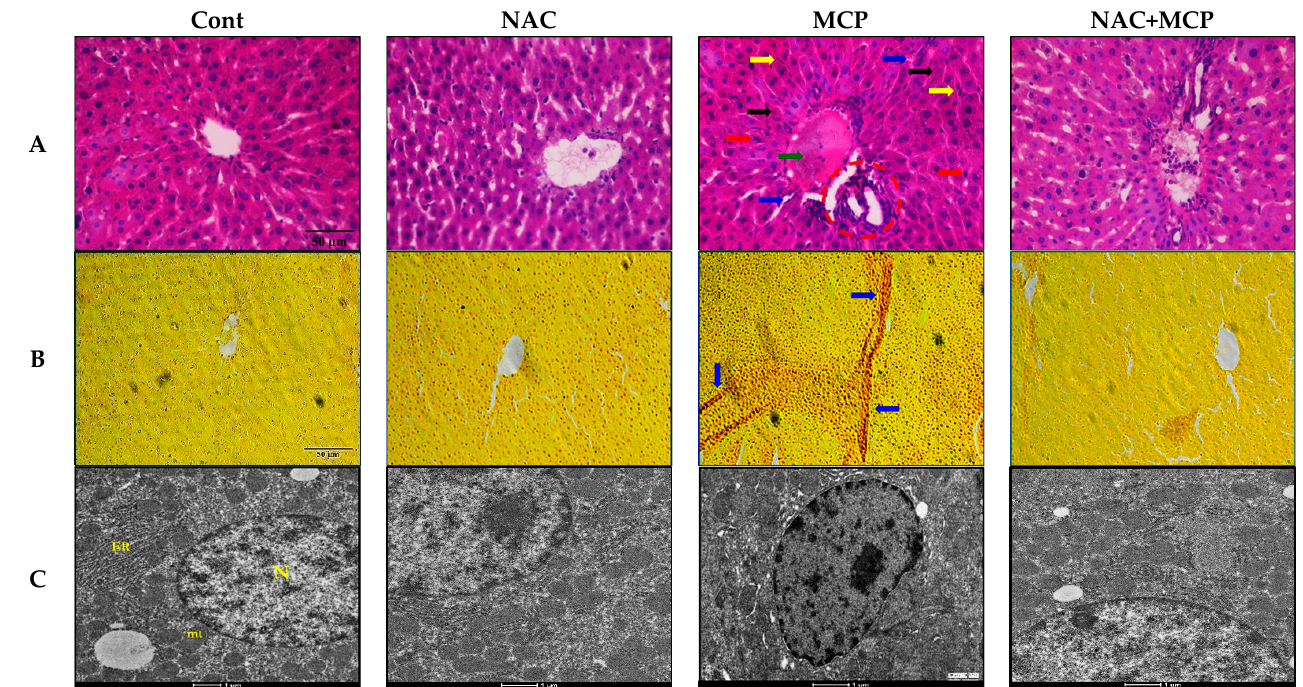
Figure 4. Photomicrograph of the liver tissue sections. ( A ) H and E staining (200*); circle indicates the area of inflammation and infiltrated cells; black arrows indicate pyknotic nuclei; blue arrows depict sinusoidal space; yellow arrows depict activated kuffer cells; green arrow indicates congestion of central vein; red arrows indicate apoptotic hepatocytes. ( B ) Van Geison’s staining (200*); arrows depict the fibrosis. ( C ) Transmission electron microscopy images; N—nucleus, ER—endoplasmic reticulum, mt – mitochondria